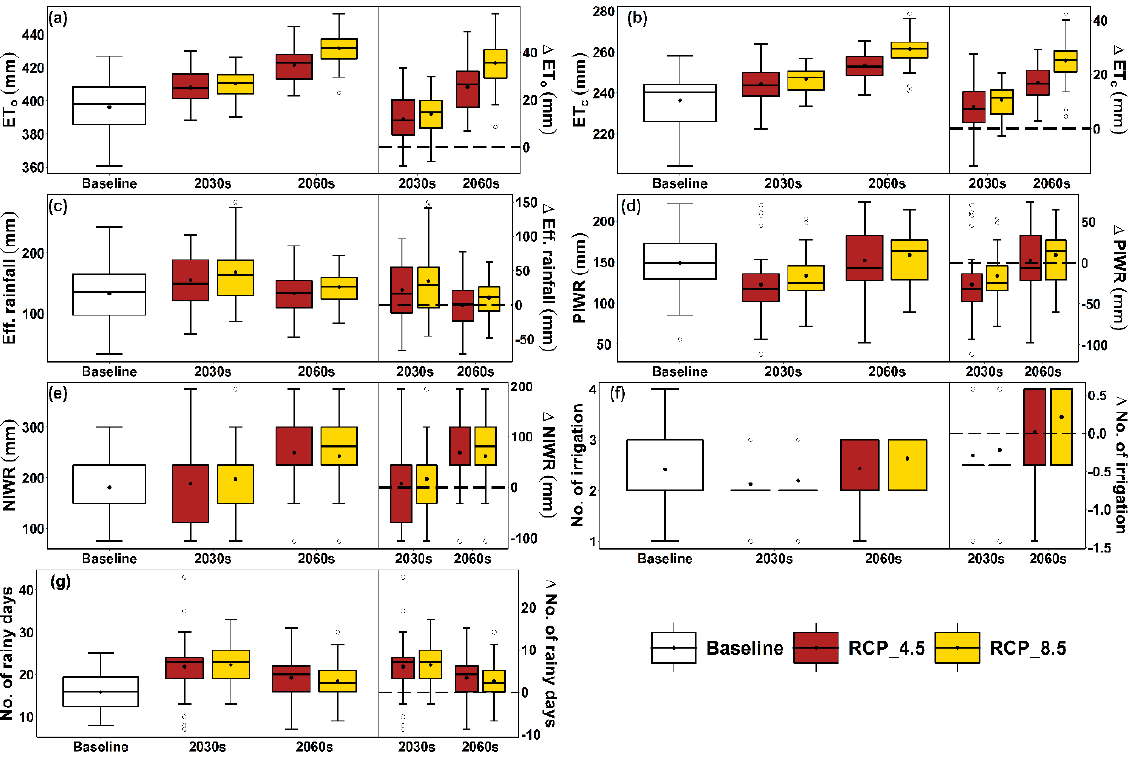
Figure 5. Wheat seasonal (November–April) cumulative ( a ) reference evapotranspiration (ET o ), ( b ) crop evapotranspiration (ET c ), ( c ) effective rainfall (ER), ( d ) potential irrigation water requirement (PIWR), ( e ) net irrigation water requirement (NIWR), ( f ) number of irrigations, and ( g ) number of rainy days (N) during the baseline (1980 − 2010), 2030s, (2021 − 2050) and 2060s (2051 − 2080).